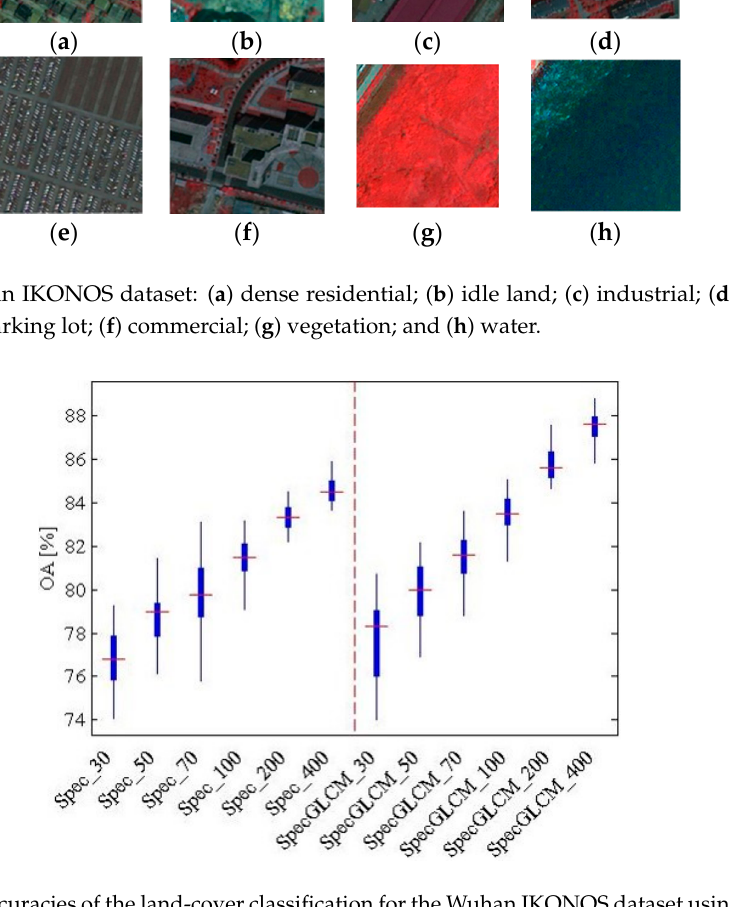
Figure 14. The accuracies of the land-cover classification for the Wuhan IKONOS dataset using different features and samples. The underscore connects the feature and the number of samples of each class.